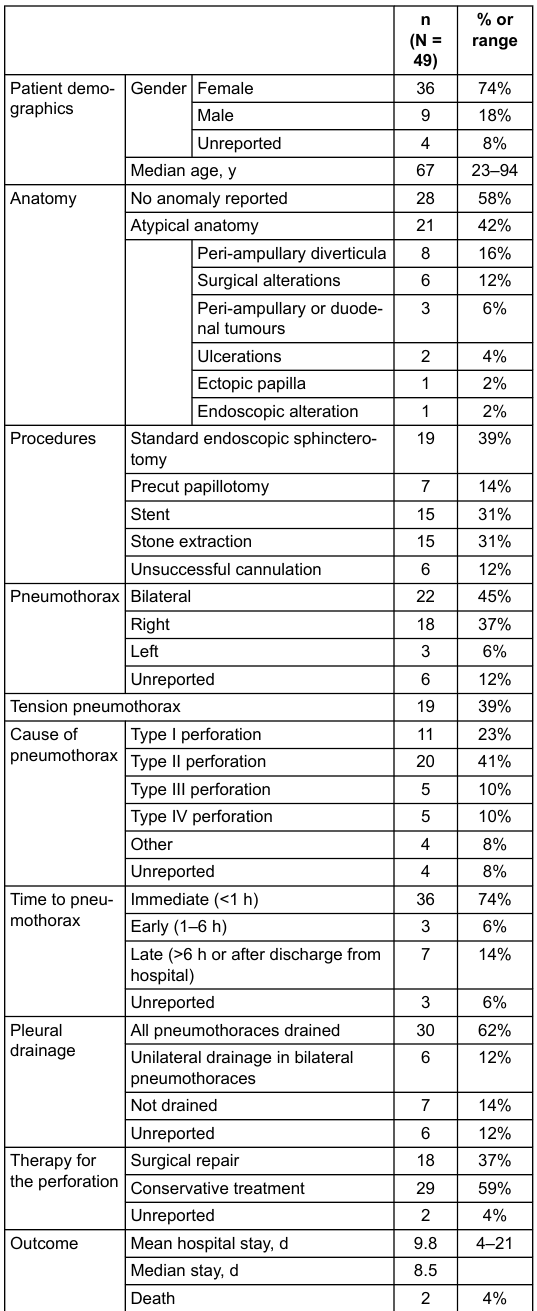
Table 3: Summary of